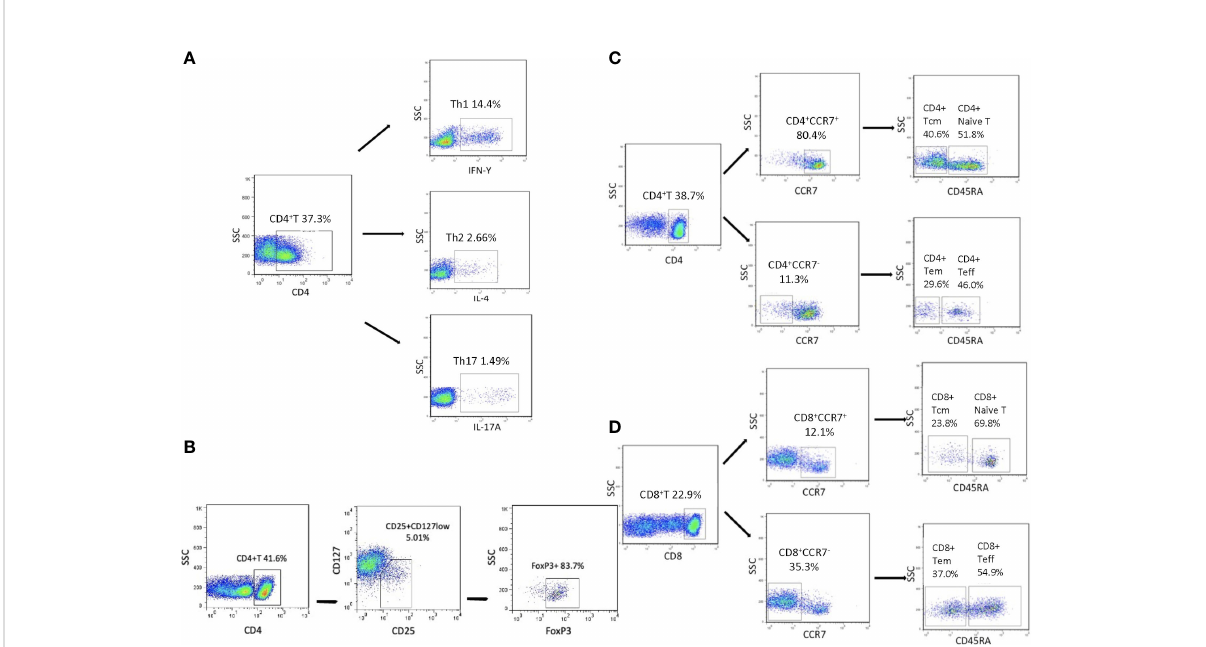
FIGURE 1 Flow cytometry of peripheral T-cell subsets. (A) Representative dot plot showing the gating strategy for IFN- g + CD4 + T, Th2 and Th17 cells. (B) Representative dot plot showing the gating strategy for Tregs. (C, D) Representative dot plot showing the gating strategy for naïve and memory T cells gated on CD4 + T/CD8 + T